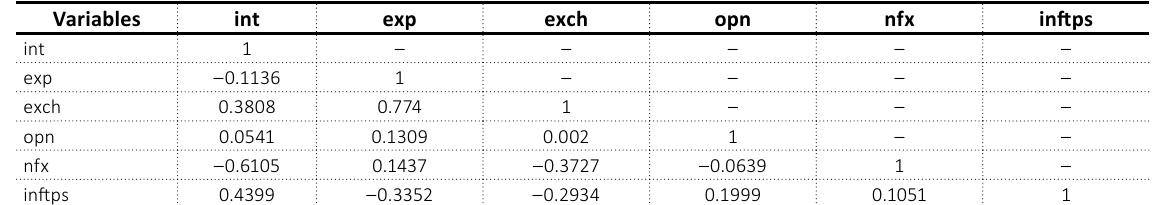
Table 3. Pairwise correlation analysis